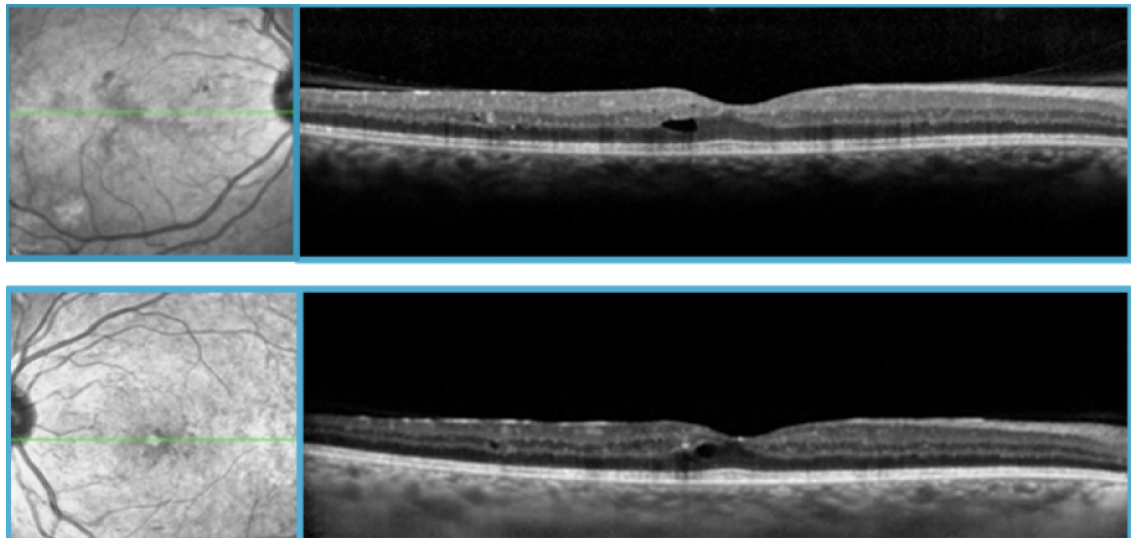
Figure 1: SD-OCT at presentation OU showing a small intraretinal microcyst with no significant macular thickness. No foveal involvment is shown.